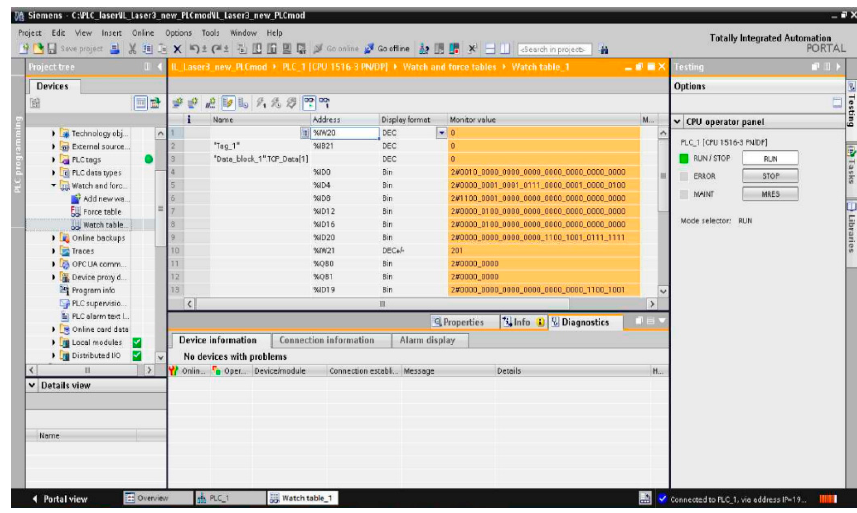
Figure 13. Recording of the measurement of the diameter deviation with a laser triangulation sensor. The defects on the machined surface documented according to Figure 14 were imaged using a Carl Zeiss Primotech D/A ESD microscope.